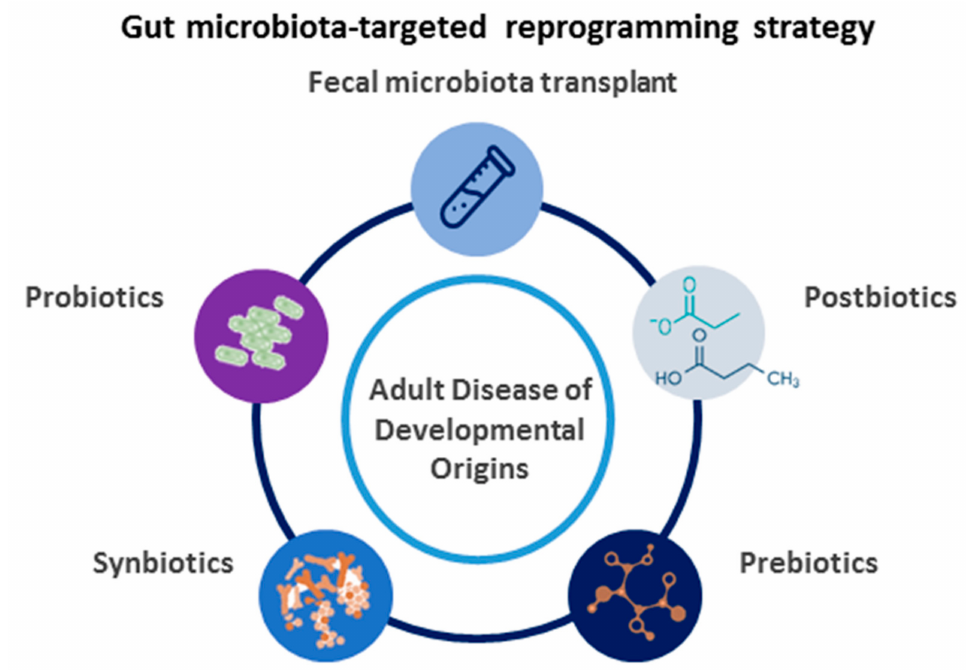
Figure 2. Schematic diagram of the potential gut microbiota-targeted therapies used for adult disease of developmental